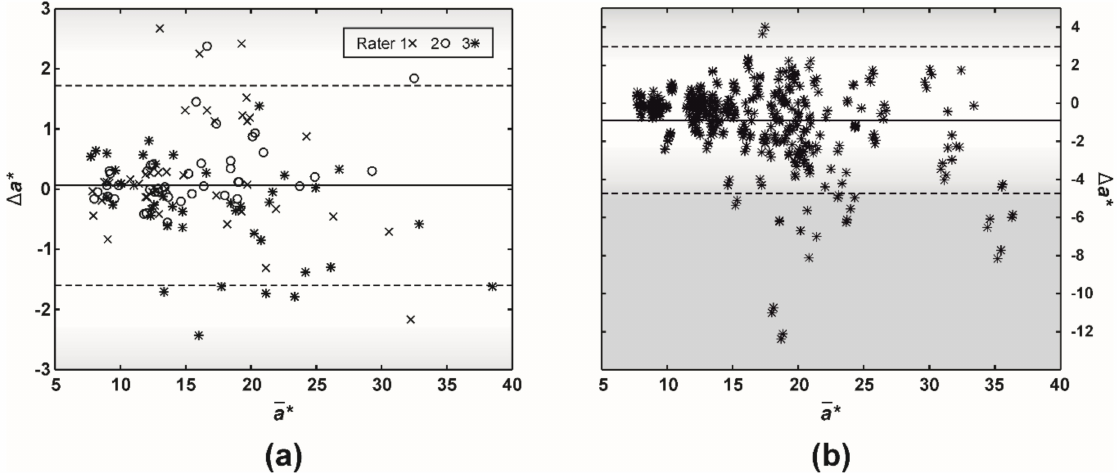
Figure 6. A difference (Bland-Altman) plot of a* (CIELAB color space) misestimates between ( a ) a single (intra-) and ( b ) multiple raters (inter-rater absolute agreement). The full and two dashed lines represent the difference mean and 95% limits of agreement (i.e., 1.96 × of SD), respectively. Gradients of gray color mark just-noticeable difference (JND, the range of 2.3–5.0), which corresponds to the human eye capability to spot a difference between two